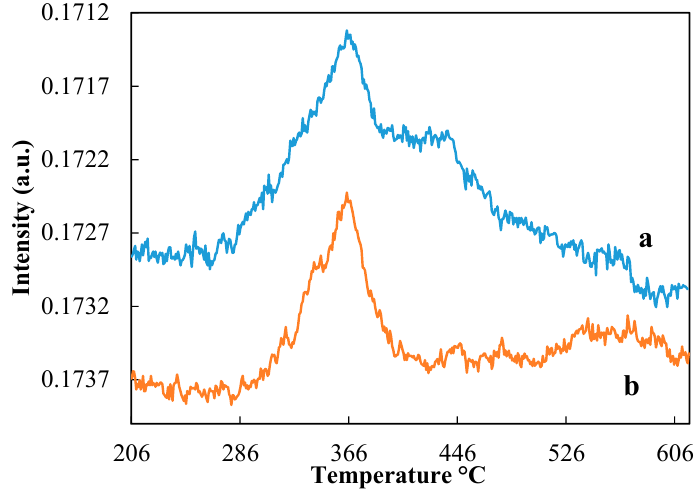
Figure 4. H 2 -TPR profiles of ( a ) natural diatomite and ( b ) food-grade diatomite.